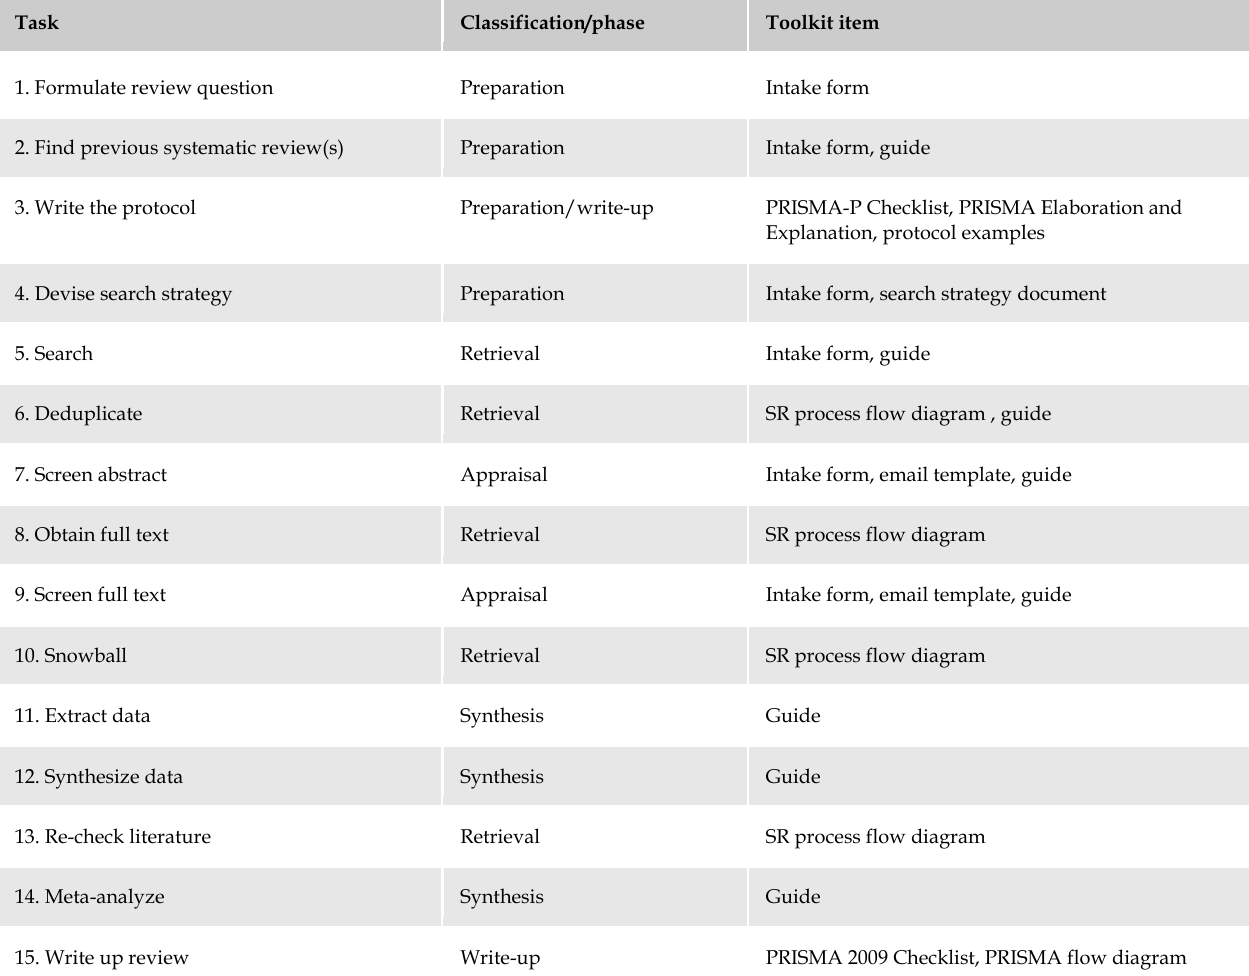
Table 1 Systematic review tasks, phases, and corresponding toolkit items